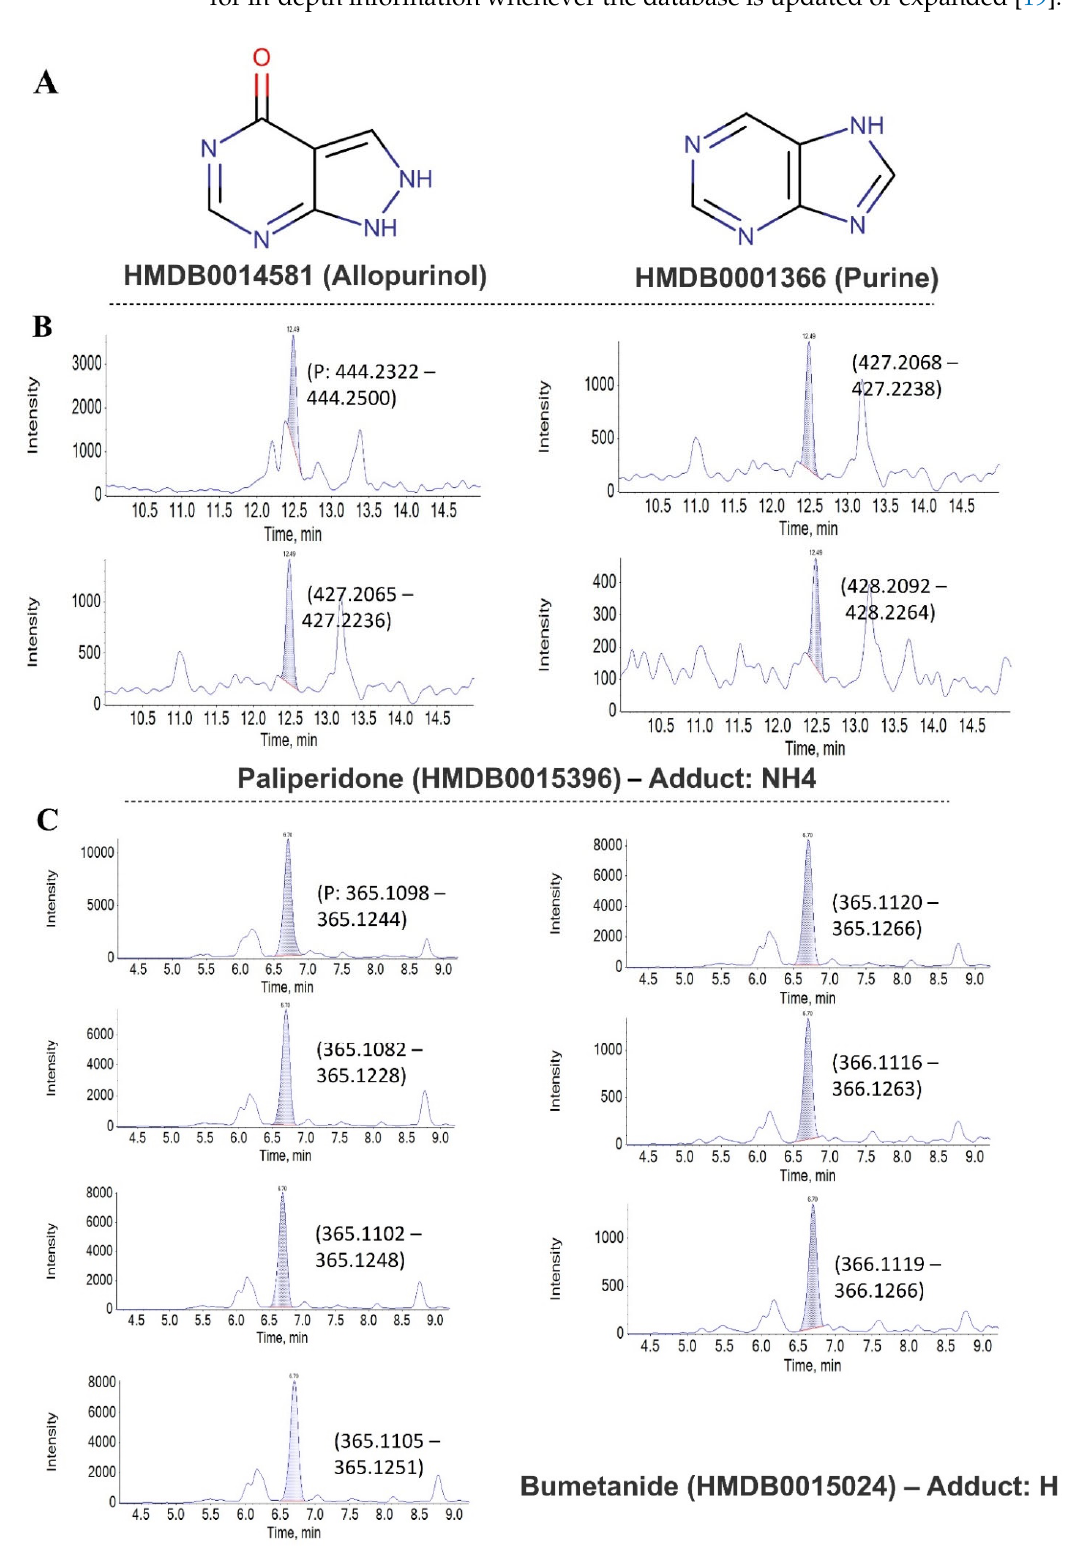
Figure 4. False-positive identified compound: ( A ) clarifies structure similarity, ( B ) the parent with the ammonium adduct without further fragmentations, and ( C ) the protonated form of the